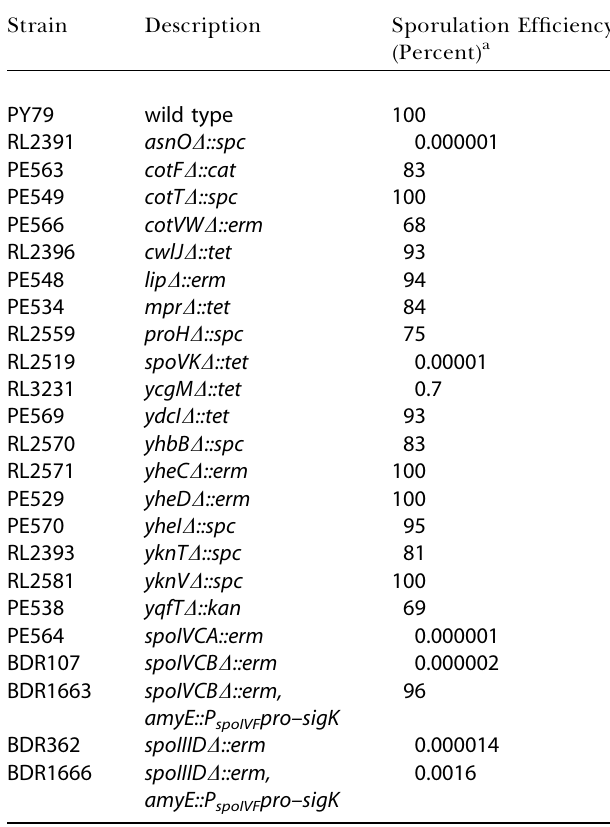
Table 3. Systematic Inactivation of SpoIIID-Activated